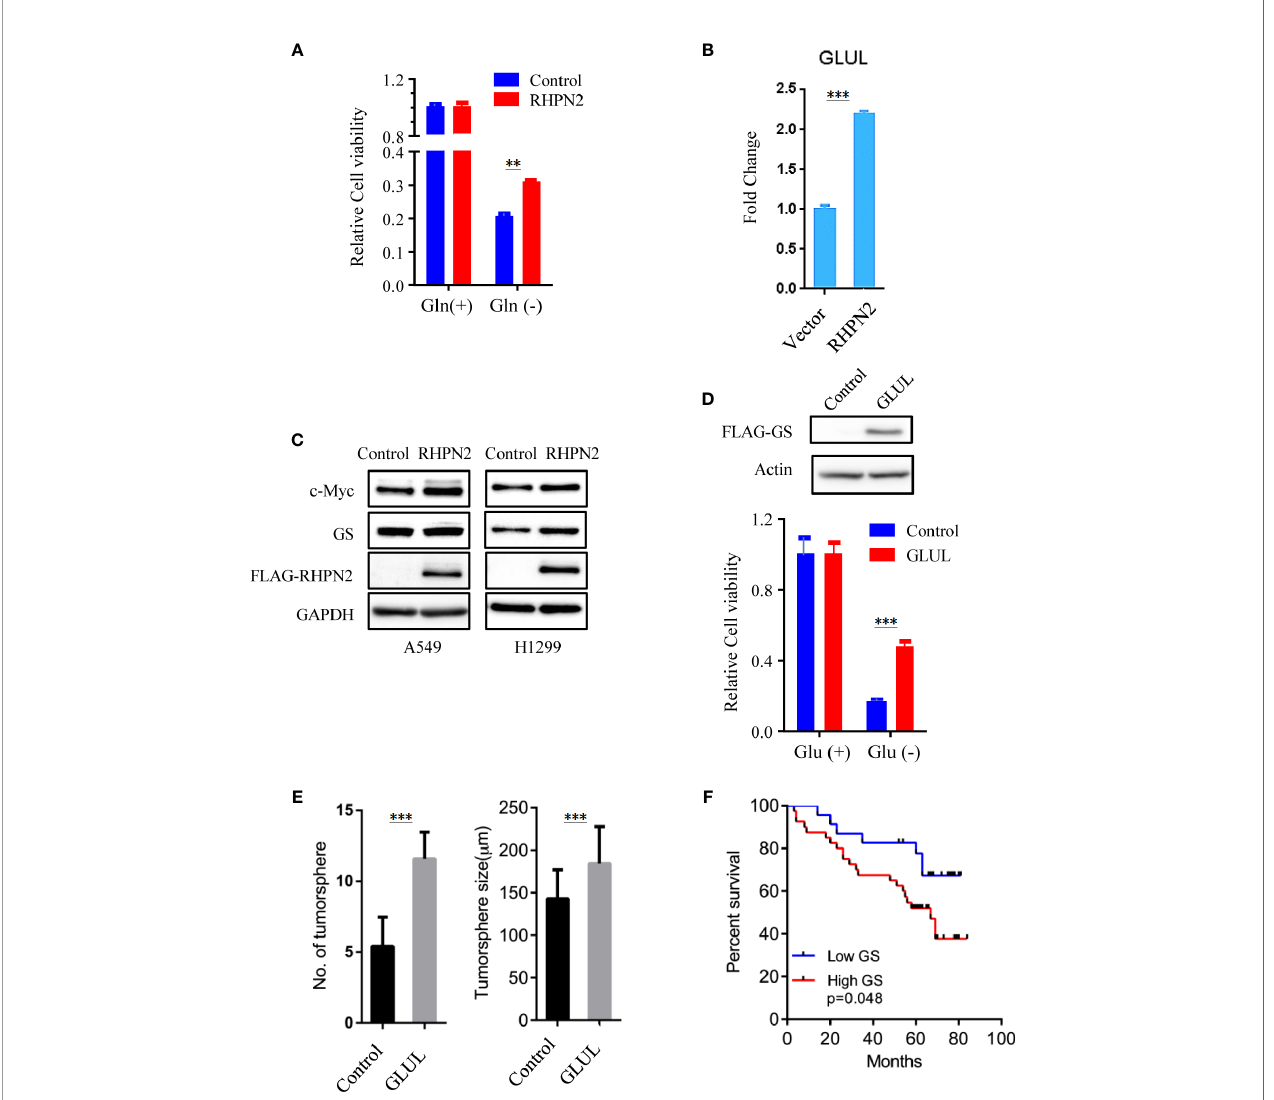
FIGURE 5 | RHPN2 upregulates GLUL expression and confers sensitivity to glutamine deprivation. (A) MTT assay to assess the proliferation of A549 cells stably expressing FLAG-RHPN2 or Vector control in the presence or absence of glutamine. (B) RT-qPCR analysis of expression of GLUL in A549 cells stably expressing RHPN2 or vector control. (C) Immunobloting analysis of cell lysates from A549 and H1299 cells stably expressing RHPN2 or vector control. (D) MTT assay to assess the proliferation of A549 cells stably expressing FLAG-GLUL or Vector control in the presence or absence of glutamine. (E) Quantitative results of tumorsphere number and size of H1299 cells expressing GLUL or vector control. (F) Kaplan-Meier overall survival curves for the patients with lung adenocarcinoma with different levels of glutamine synthetase (GS). **p < 0.01 and ***p < 0.0001 compared with empty